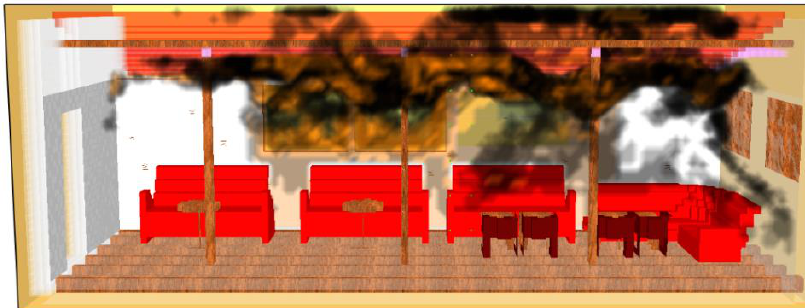
Figure 8. Fire spreading to the ceiling.